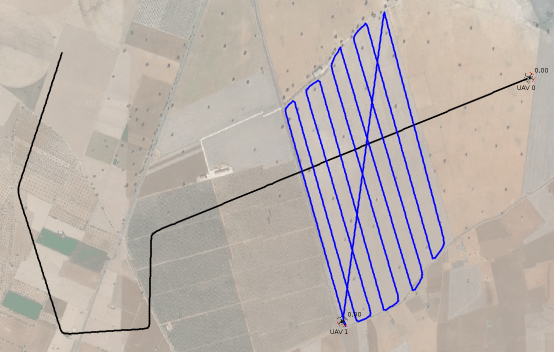
Figure 11. Collision avoided on a crop field (scenario